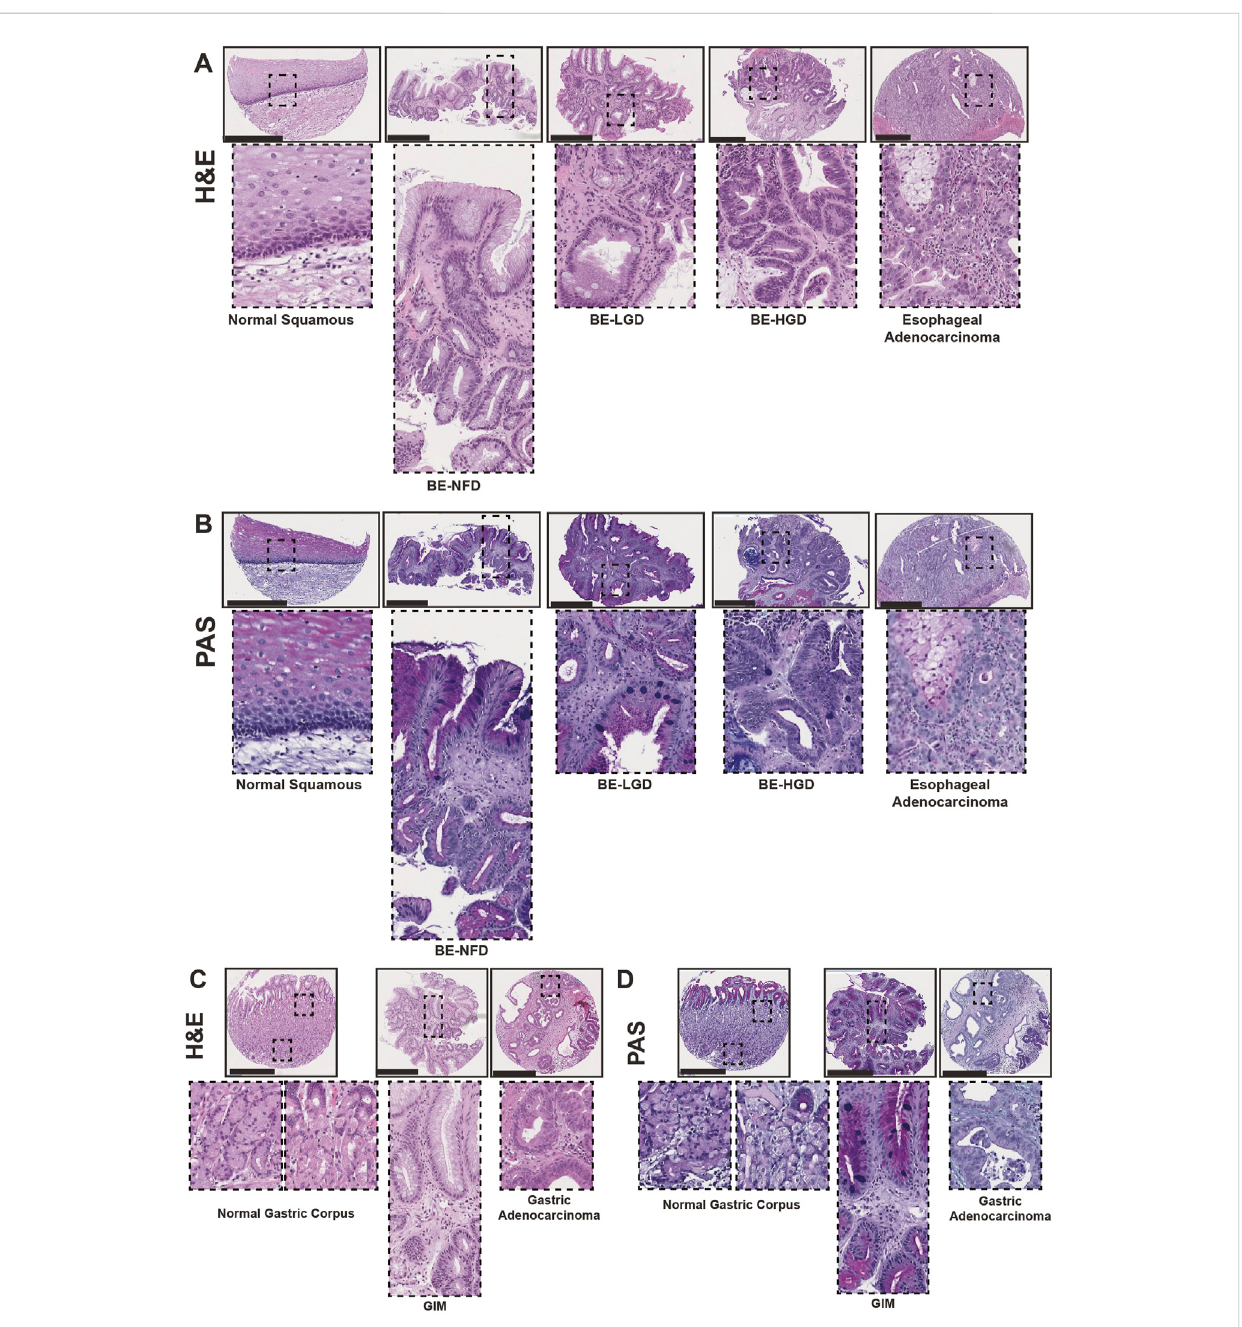
FIGURE 1 Humantissuemicroarrayofnormalsquamous-BE-EAC andnormalgastricgland-GIM-GA progressionsequence. (A) Morphologyofrepresentative H&E staining from the human tissue microarray of esophageal cases, from left to right: normal squamous, BE-NFD, BE-LGD, BE-HGD, and EAC. (B) Morphology of representative PAS staining from the human tissue microarray of esophageal cases, same sequence as in (A) . (C) Morphology of representative H&E staining from the human tissue microarray of gastric cases, from left to right: normal gastric corpus (left inset from base of the glands,rightinsetfromthesurfaceoftheglands),GIM,andGA. (D) MorphologyofrepresentativePASstainingfromthehumantissuemicroarrayofgastric cases, in the same sequence as in (C) . All scale bars, 500 μ